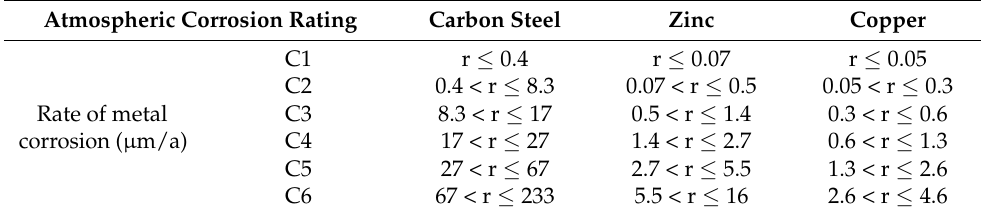
Table 4. Corrosion rates of standard metals with different corrosion